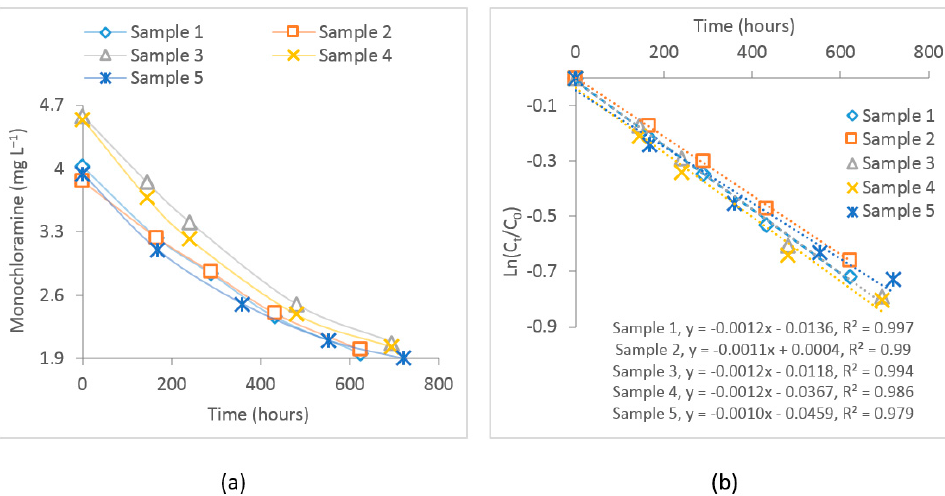
Figure 4. ( a ) Plot of the observed monochloramine decay for the experimented samples and ( b ) first– order curve fitting for these samples. C 0 represents initial monochloramine concentration, while C t represents monochloramine concentration at time t